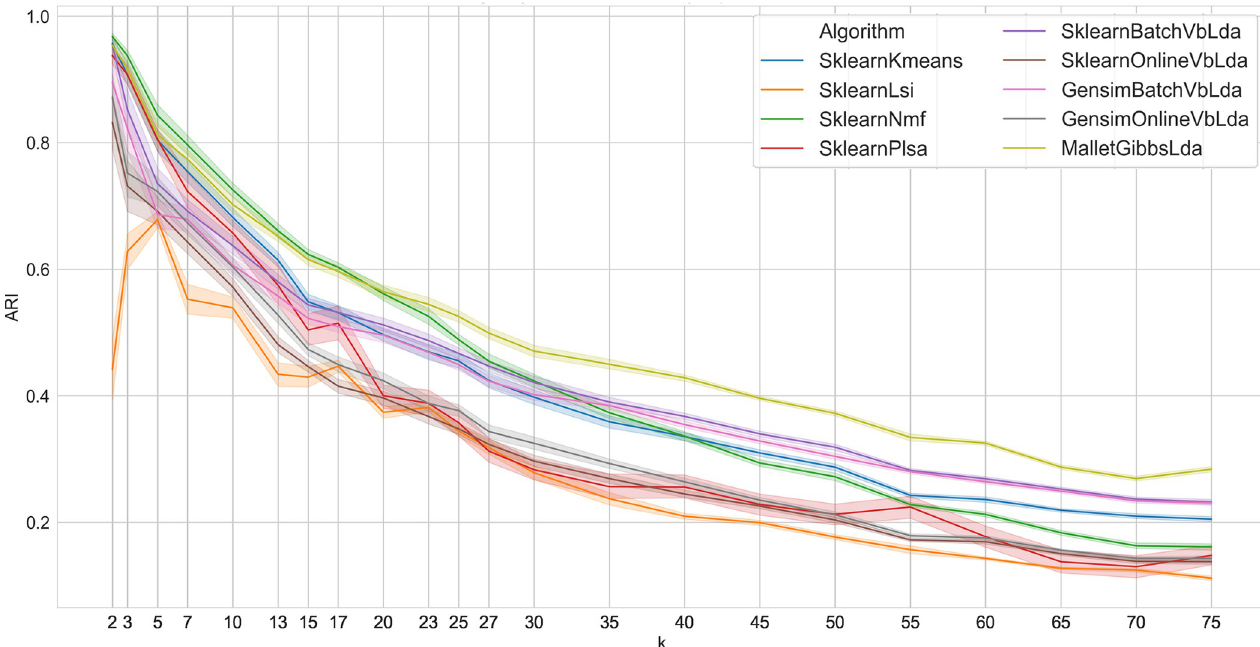
Fig 1. Average algorithm performance on all dataset series.